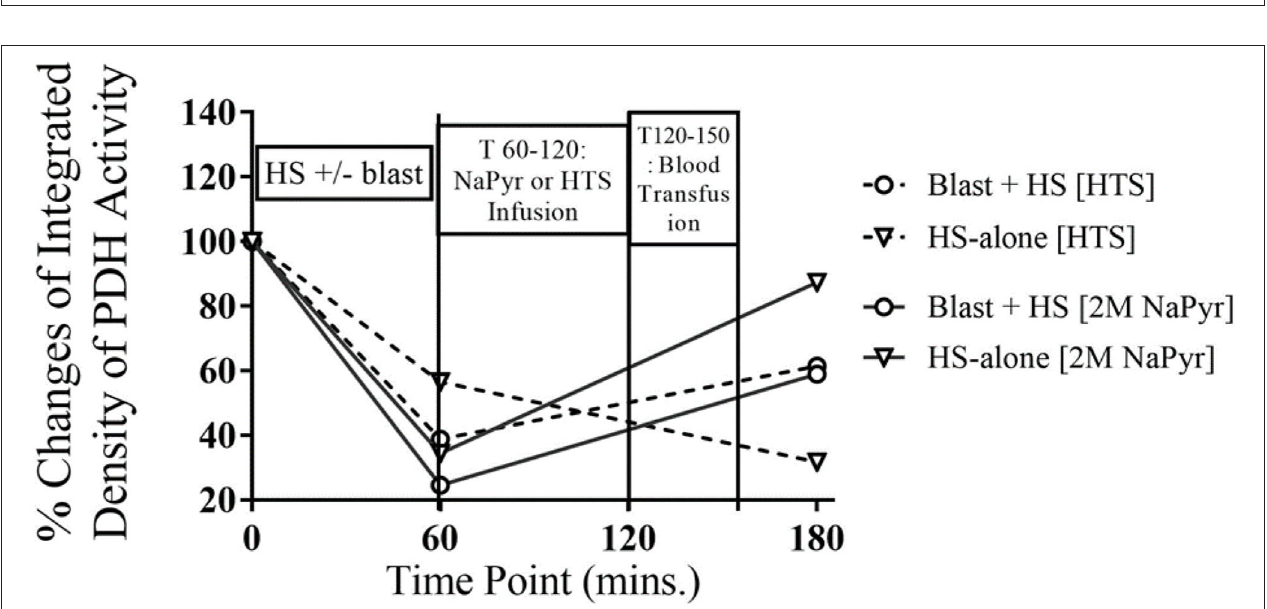
FIGURE 6 | Plasma lactate:pyruvate of 4-h survival animals at different time-points of HS and/or 20 PSI blast injury, and with either sodium pyruvate (treatment) or hypertonic saline (control) infusion. There was a statistically significant ( p < 0.001) increase in the L:P ratio after the combined blast and HS injury (T60) from the baseline value. The condition greatly improved after both infusions.